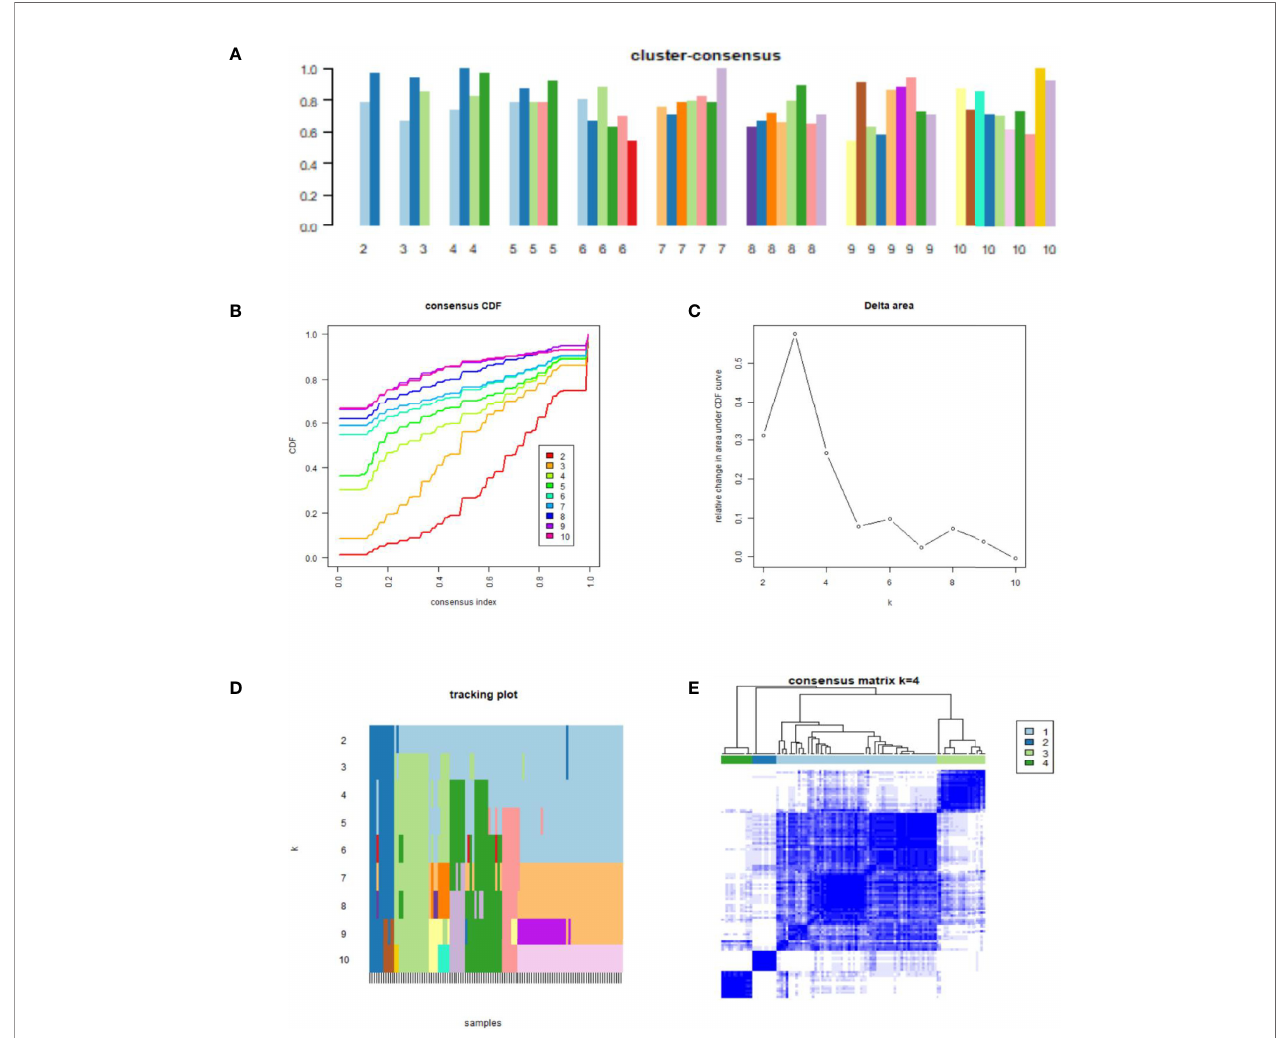
FIGURE 3 | Results of consensus clustering analysis. (A) Cluster-consensus plot. Cluster-consensus plot showing the cluster-consensus value (the mean value of the pairwise consensus values of each subtype) with different k values. The higher the value, the more stable the subtype. (B) Cumulative distribution function (CDF) plot. The CDF plot shows the CDF of each cluster (K values corresponding to different clusters) for the selection of K, and the subtype is stable when the CDF descent has a small slope. (C) Delta area plot. The delta area plot shows the relative changes in the area under the CDF curve between K and K-1. When the area under the curve increases slightly, the K value is appropriate, and the classi fi cation is stable. (D) Tracking plot. The black stripes below the tracking plot represent the samples, which shows the classi fi cation of the samples at different k values, whereas the blocks of different colors represent different classi fi cations. The classi fi cation is stable when colors of samples are scarcely changed at different K values. (E) Consensus matrix. The values of the consensus matrix are shown in white to dark blue from 0 (impossible to be clustered together) to 1 (always clustered together), and the consensus matrix was arranged according to the consensus clustering (dendrogram above the heatmap). The bars between the dendrogram and the heatmap represent the molecular subtypes. All results indicate that the sample clustering was stable and robust when the boundary of the consensus matrix was